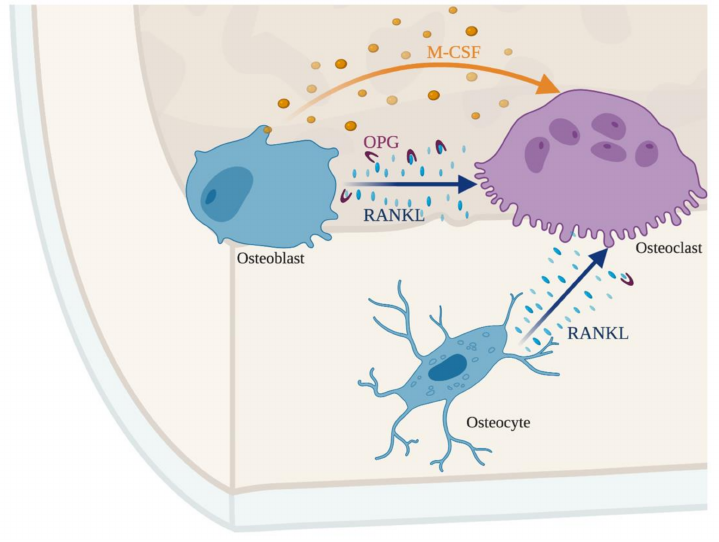
Figure 2. The crosstalk between osteoblasts, osteocytes, and osteoclasts maintains an adequate bone mass. The balance between receptor activator of nuclear factor kappa-B ligand (RANKL) and macrophage-colony stimulating factor (M-CSF) controls osteoclastogenesis. Osteoblast and osteocytes produce RANKL that binds to its receptor on the surface of osteoclasts. Simultaneously, osteoblasts secrete osteoprotegerin (OPG), a decoy receptor for RANKL. The production of OPG makes RANKL unavailable for osteoclasts, representing a second layer controlling bone resorption, dependent on